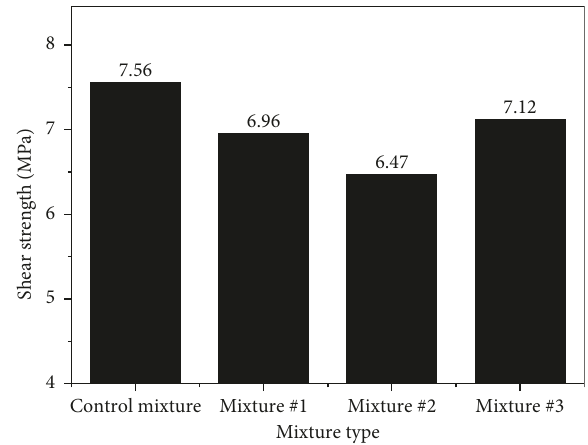
Figure 9: Results of computed shear